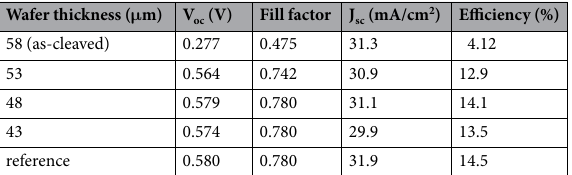
Wafer thickness ( μ m) V oc (V) Fill factor J sc (mA/cm 2 ) Efficiency (%)